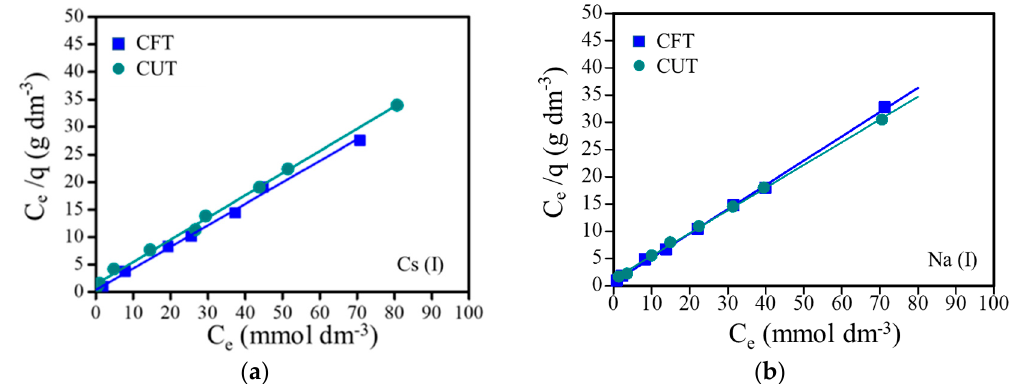
Figure 7. The Langmuir isotherm kinetic models: ( a ) Cs + ion adsorption on crosslinked fresh tea leaves (CFT) and crosslinked used tea leaves (CUT) adsorbents, ( b ) Na + ion on CFT and CUT adsorbents, adsorbent weight = 0.05 g, solution volume = 10.0 cm 3 , pH e = 7.0 ± 1.0 (Cs + ) and 7.5 ± 0.5 (Na + ), shaking time = 24 h.